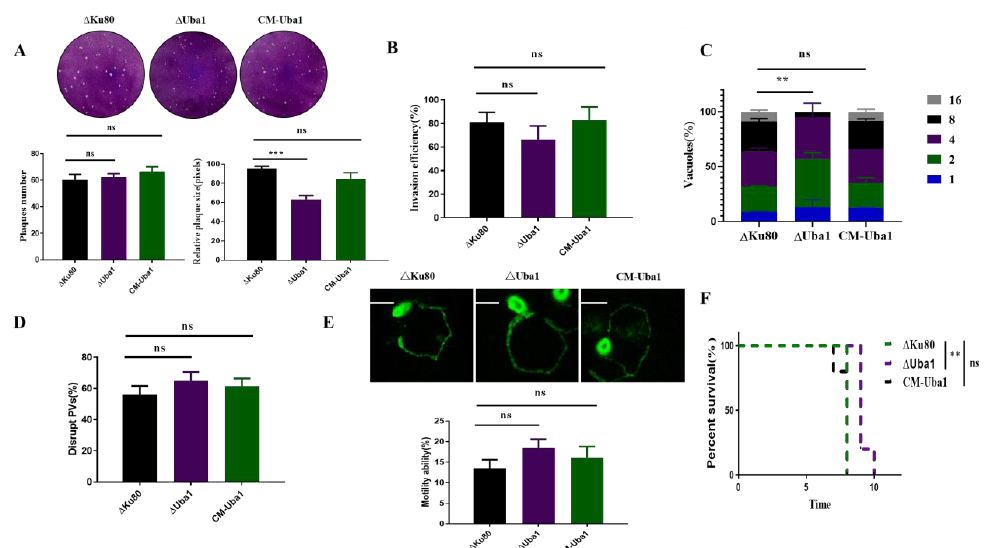
Figure 5. Phenotypic consequences of TgUba1 disruption. ( A ) Plaque assay of ∆ Uba1 parasites. Parasites were added to the DF-1 monolayer for 8 days and the size of the lysis plaques was measured. Values were the mean standard error of the mean value and area of plaques (30 plaques were measured in each condition) from one of the two representative experiments. ns, p > 0.05, ***, p < 0.001. ( B ) Invasion assay of CM-Uba1 and ∆ Uba1 parasites. n = 3, a representative experiment from two independent assays. ns, p > 0.05, indicates non-significant. ( C ) Proliferation assay of CM-Uba1 and ∆ Uba1 parasites. n = 3, a representative experiment from 2 independent assays. ns, p > 0.05. **, p < 0.01. ( D ) Percentage egress of each strain calculated following treatment with A23187 at 24 h post-infection. n = 3, ns, p > 0.05. ( E ) Movement trajectory statistical data. Gliding was observed using IFA as the surface protein SAG1, which was left behind as the parasite glides. ns, p > 0.05. Scale bar, 5 µ m. ( F ) Survival curves of mice being infected with maternal ∆ Ku80, ∆ Uba1 or CM-Uba1 parasites at a dose of 500/mice. The results of one of three similar experiments were shown and analyzed by the Gehan–Breslow Wilcoxon test. ns, p > 0.05. **, p <